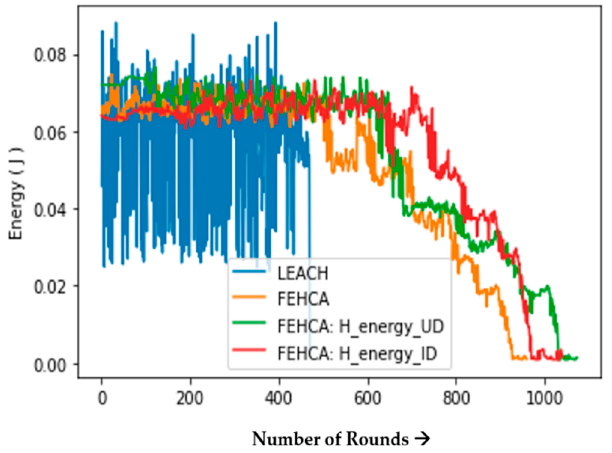
Figure 20. Energy dissipation per round in LEACH and FEHCA when BS is positioned outside the deployment area.